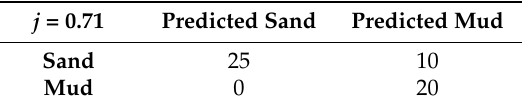
Table 10. Confusion matrix for classification at Llansteffan using an artificial neural network fed with HSV and NIR data channels. Calculated j values are given in the upper left cell.